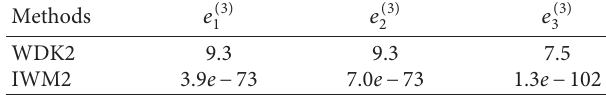
Table 3: Simultaneous finding of all roots.